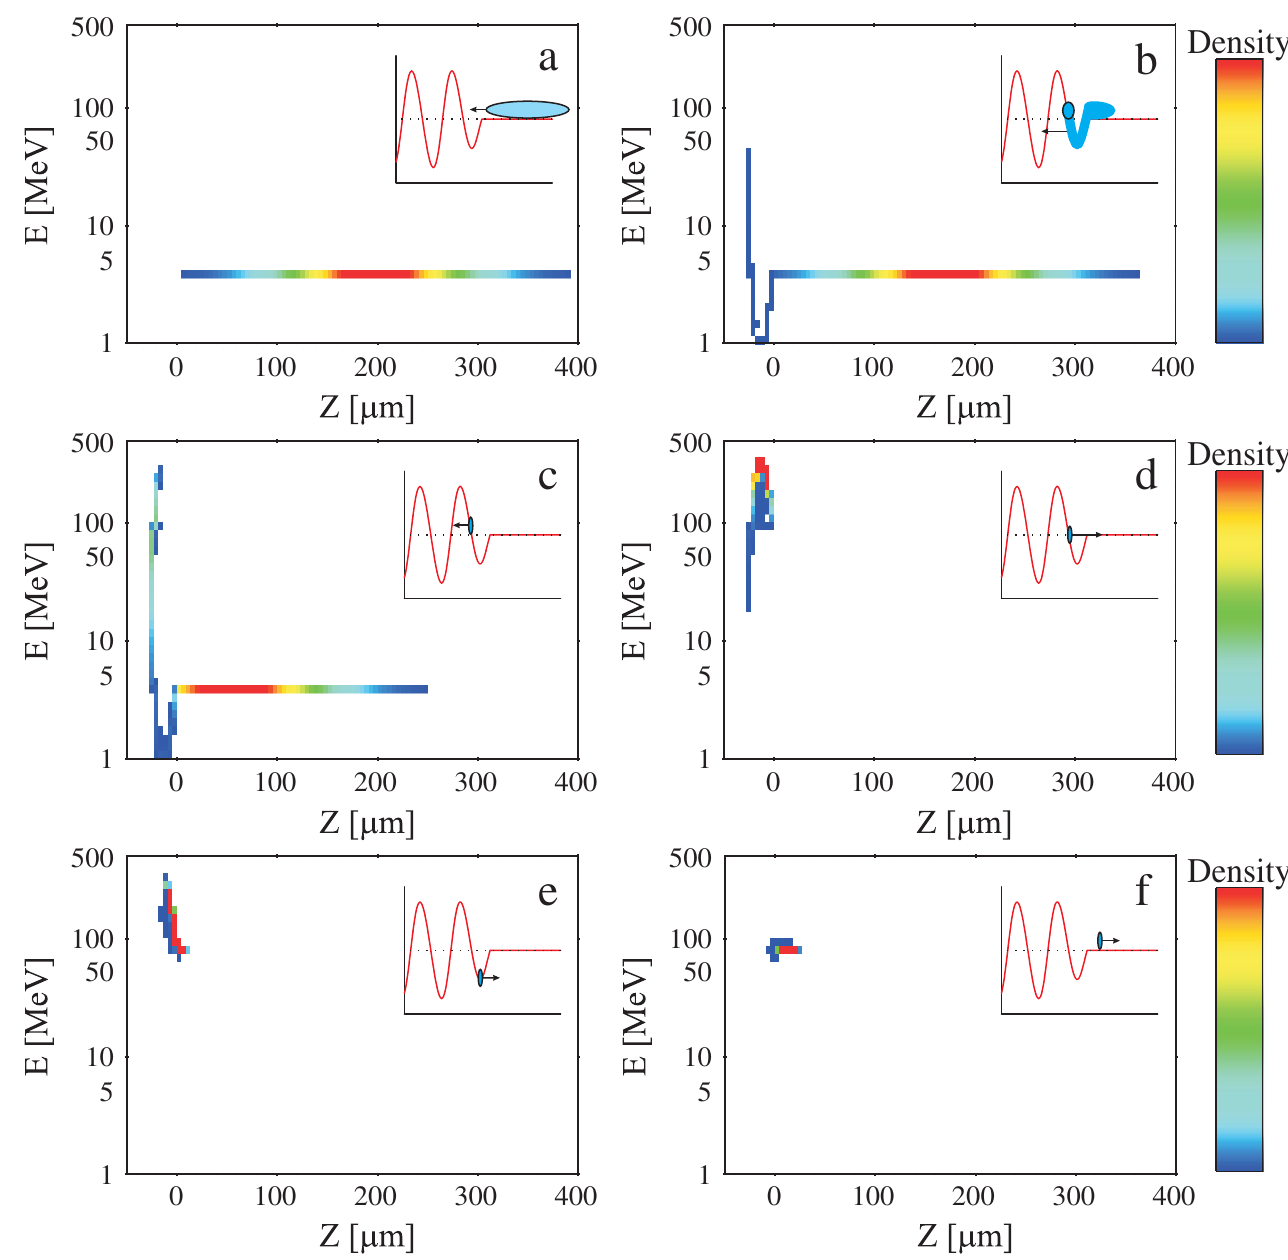
FIG. 2. (Color) Density plots of the simulation results for the energy and bunch length evolution during compression of a 0.5 ps electron bunch. The insets are the equivalent situations from Fig.